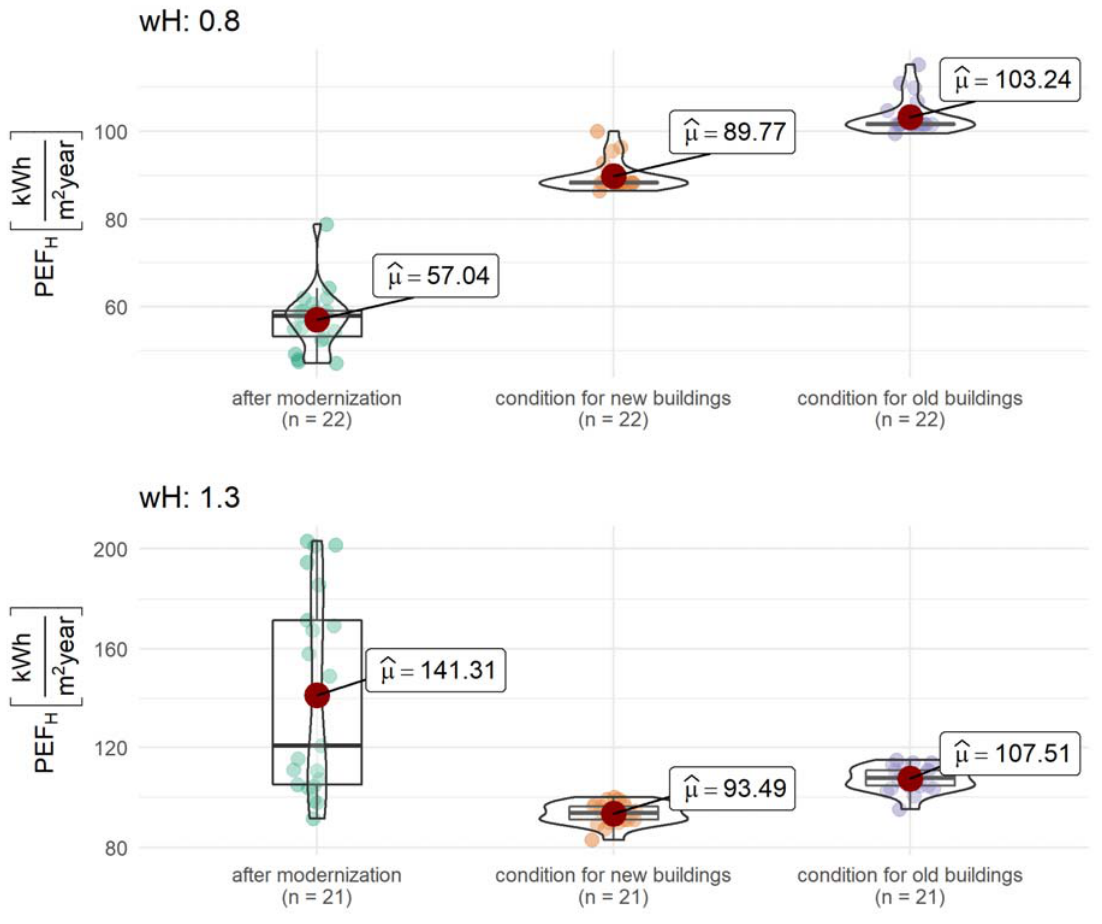
Figure 7. Comparison of the actual annual primary energy consumption factor ( PEF H ) after modernization with the boundary conditions for the modernized (old) and new buildings, divided into groups depending on the non ‐ renewable primary energy input coefficient.